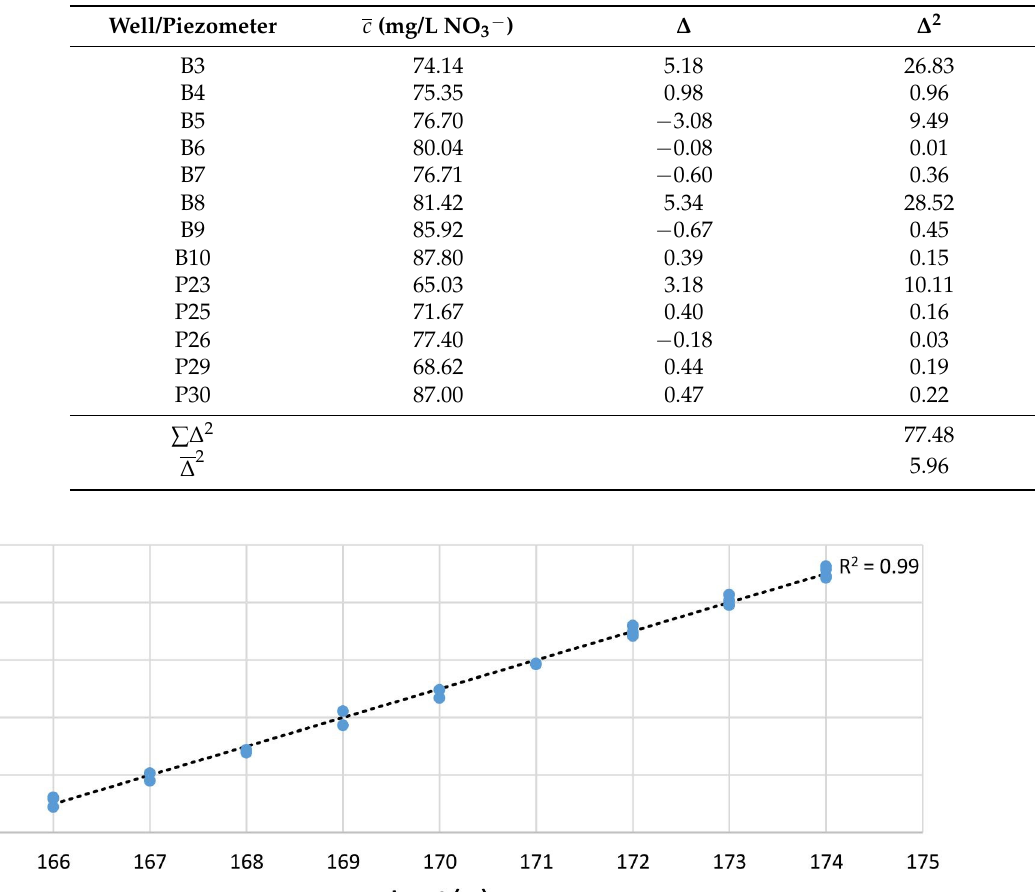
Table 2. Arithmetic means of nitrate concentration at control points and deviation values obtained by nitrate pollution propagation simulation.